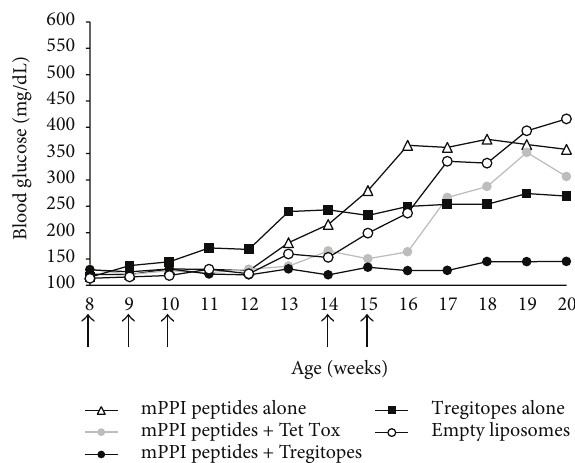
Figure 5: Study 2—prevention of T1D in NOD mice using Tregit- opes . When co-administered with the “target” antigen (five murine preproinsulin or mPPI peptides) in liposomes, treatment with four Tregitope peptides (mouse 167 and 289 and human 167 and 289) completely suppressed the development of T1D in NOD mice. Arrows represent time points when treatments were administered. Black symbols represent groups receiving Tregitopes with (circle) or without (square) target antigen. White circles represent the vehicle control group. Antigen peptides alone are indicated by white triangles, and antigen peptides with an irrelevant MHC-binding peptide by gray circles. Mice receiving liposomes alone (white circles) had a 67% incidence of diabetes at 20 weeks of age compared to 38% in mice receiving Tregitopes alone (black square). None of the mice receiving Tregitopes with antigen (black circles) developed